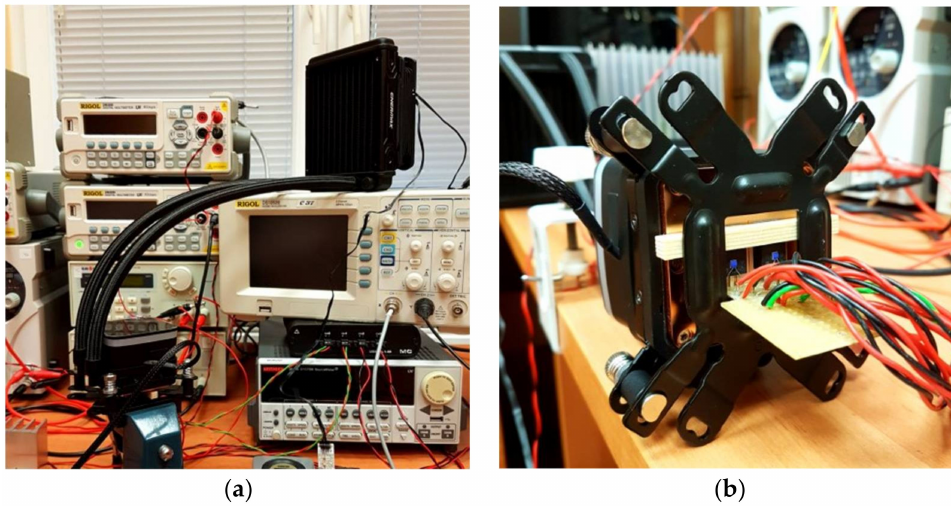
Figure 6. Cooling system ( a ) H and ( b ) the manner of attaching the investigated MOSFETS to the water block of this